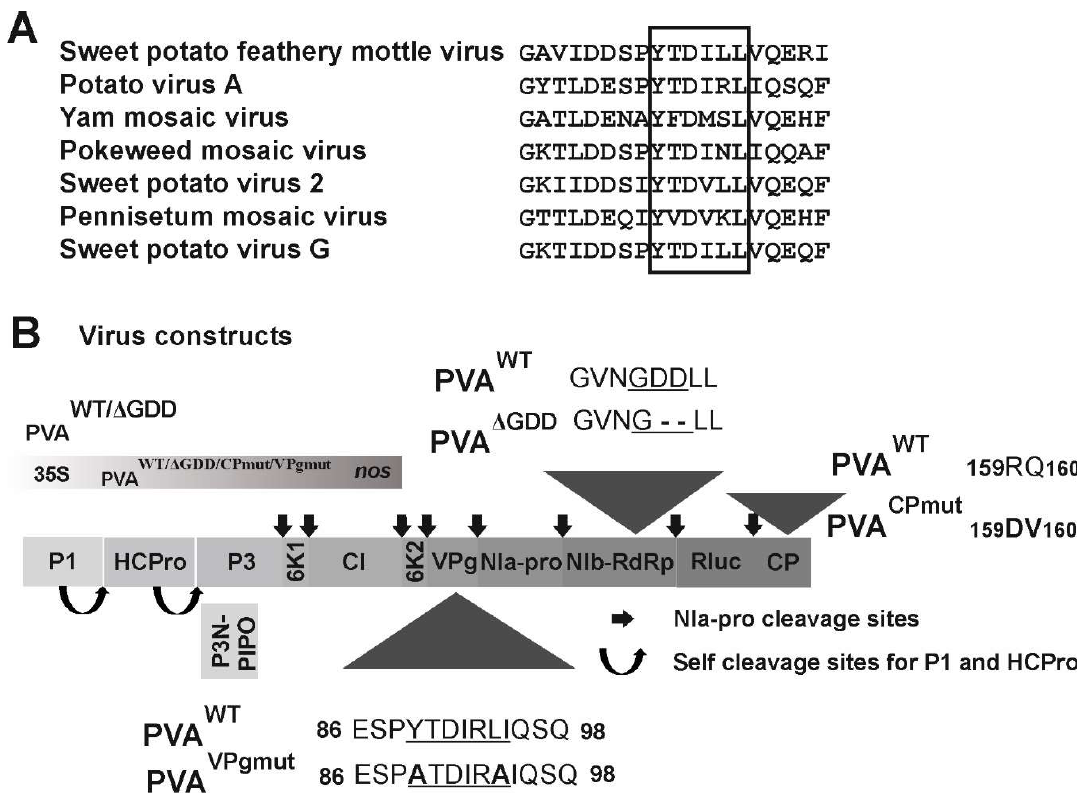
Figure 1. eIF4E-binding motif Tyr-X-X-X-X-Leu-phi (YXXXXLΦ) within potato virus A (PVA) viral protein genome-linked (VPg). ( A ) Alignment of the YXXXXLΦ motives in potyviruses. Out of the 112